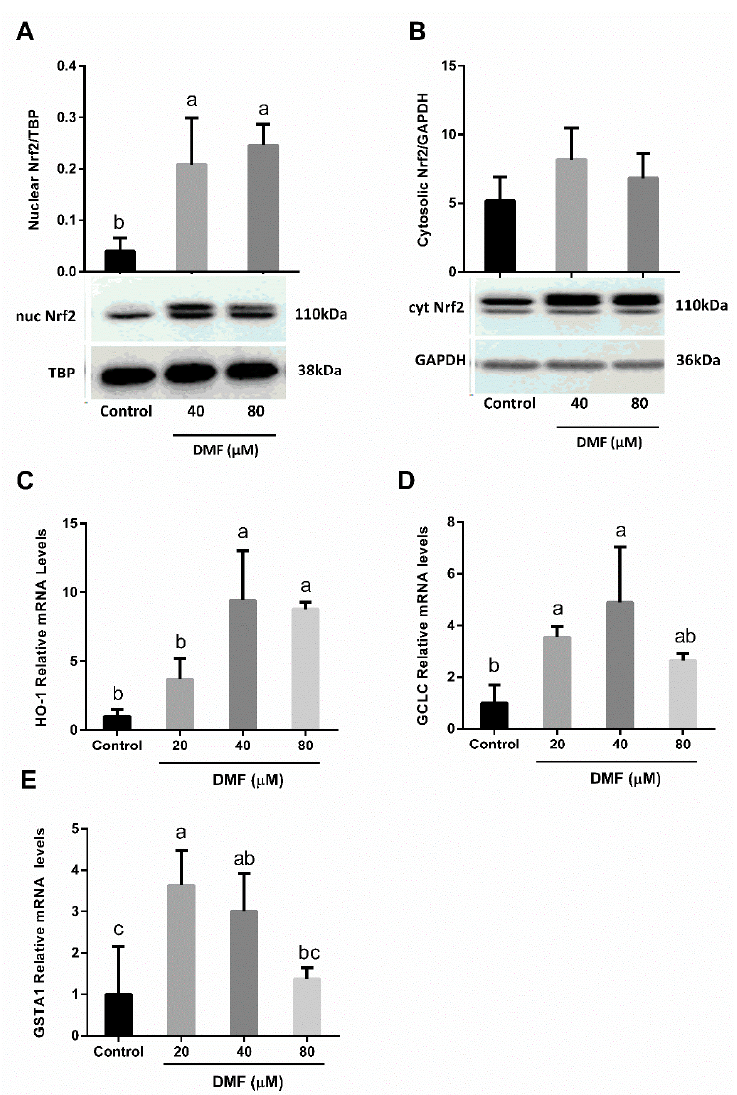
Figure 5. The effect of DMF on Nrf2 activation. ( A , B ) Nrf2 protein expression in AML12 hepato- cytes treated with 40, or 80 µ M DMF for 6 h and ( C – E ) Nrf2-related genes expression in AML12 hepatocytes treated with 20, 40, or 80 µ M DMF for 6 h. Means with different letters are statistically different ( p < 0.05).